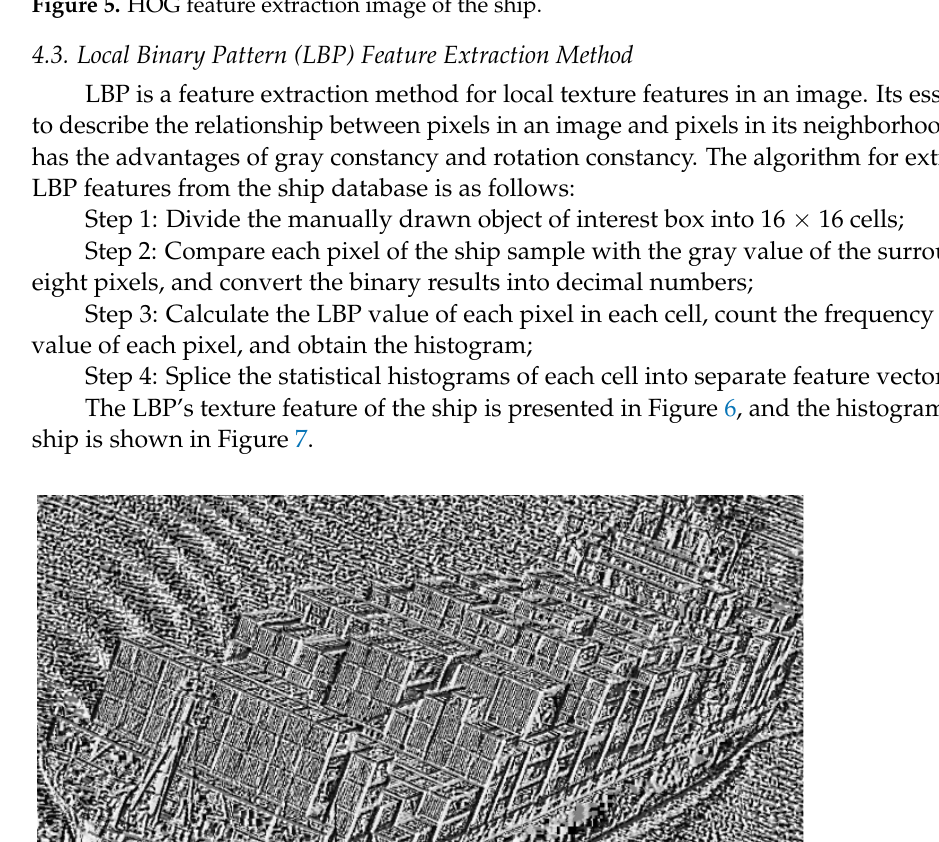
Figure 5. HOG feature extraction image of the ship.